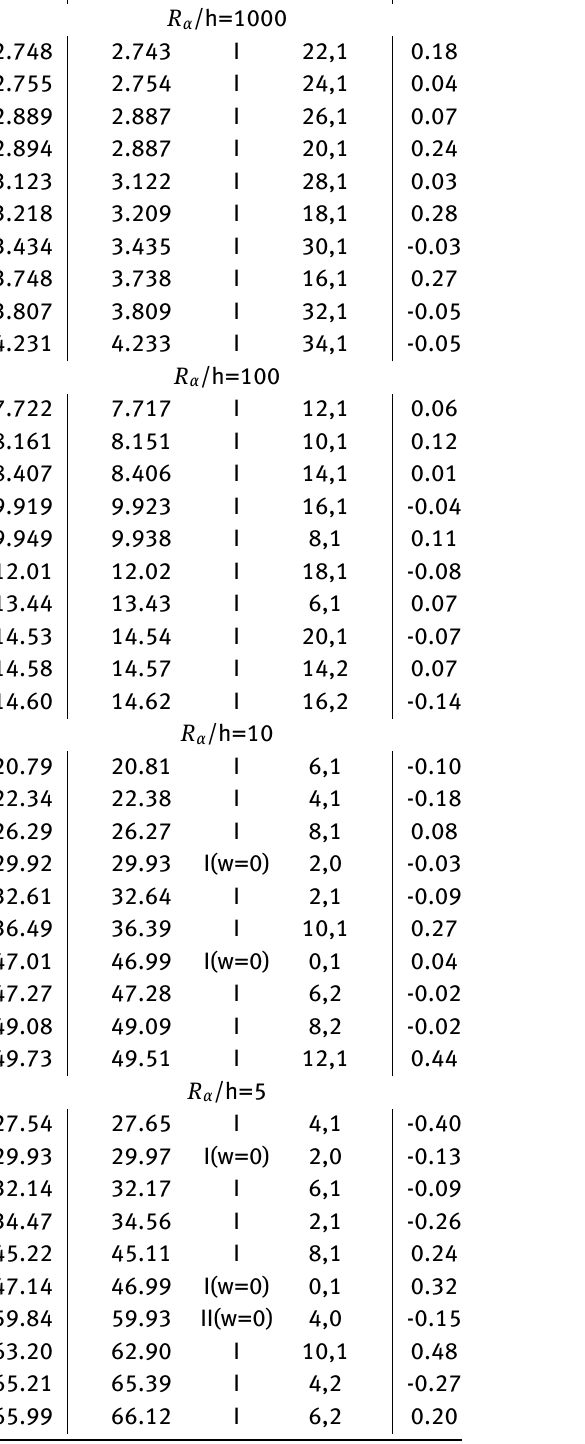
Table 16: Ninth benchmark, simply supported composite plate 90 ∘ /0 ∘ /90 ∘ /0 ∘ with thickness ratios a/h=1000, a/h=100, a/h=20 and a/h=10. First ten frequencies in Hz, comparison between the present 3D exact solution and the 2D FE solution via Nastran. The error is calculated as ∆ (%) = FE −3 D × 100 3 D